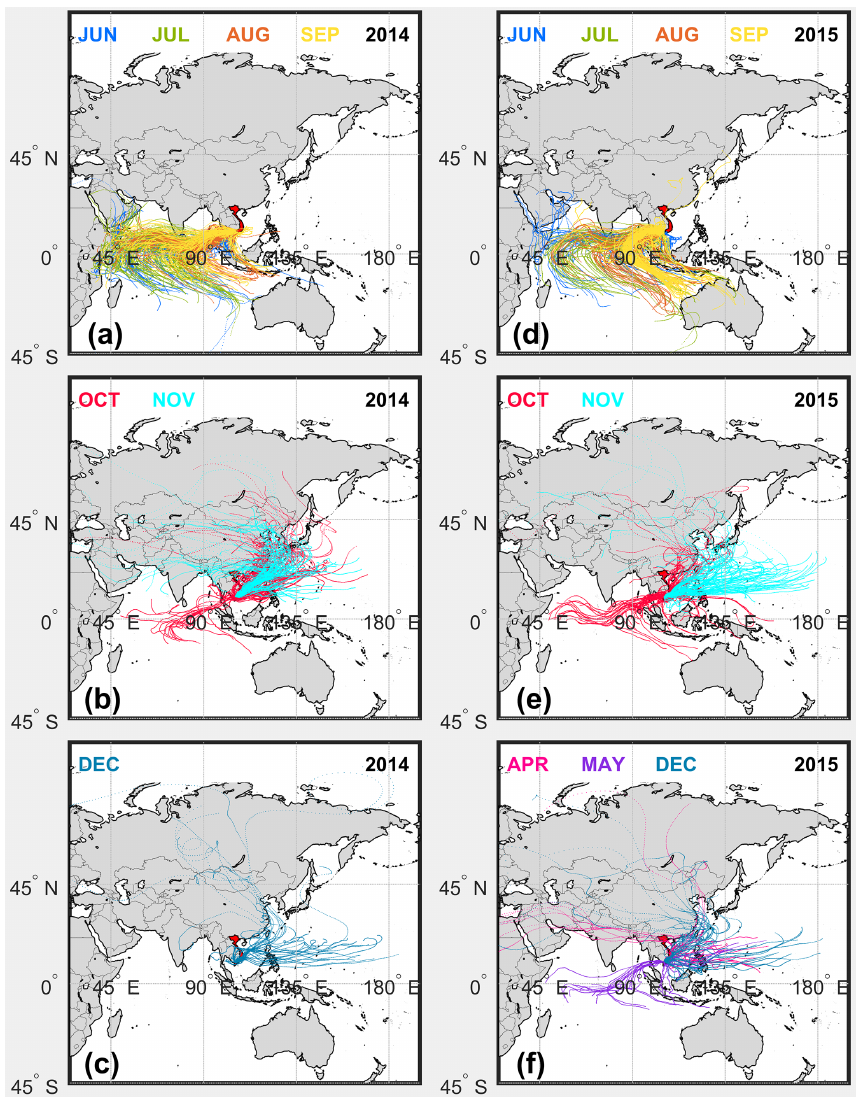
Figure 5. Back-trajectories indicating potential moisture sources of precipitation (plotted only for days with precipitation) at An Long station for the barometric surfaces at 850hPa between June 2014 and December 2015. (a) – (c) show the results for 2014, (d) – (f) for 2015; top row (a, d) early rainy season (June–September), middle row (b, e) late rainy season (October–November), bottom row (c, f) dry season (December–May). In January, February, and March 2015 no rainfall was